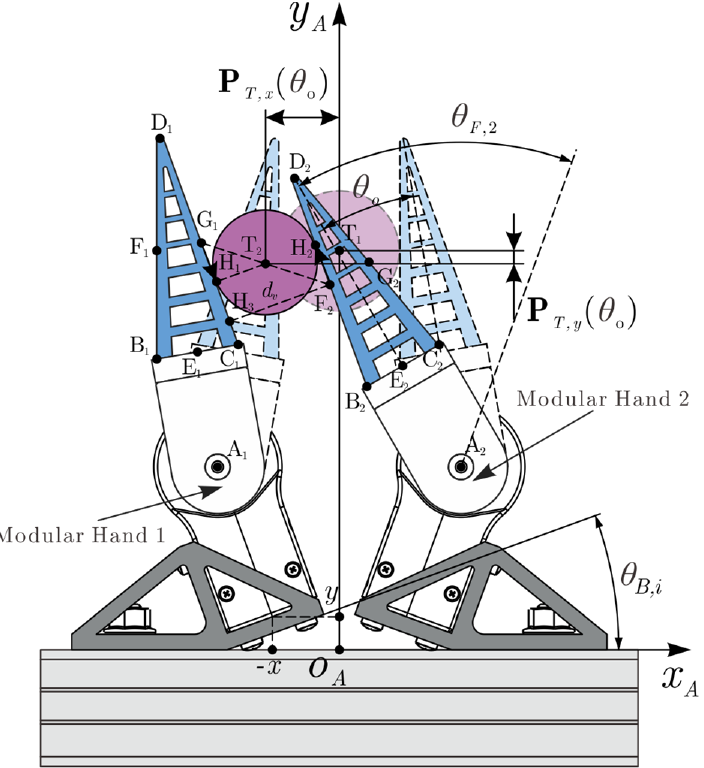
Figure 4. Multi-hand cooperative operation.